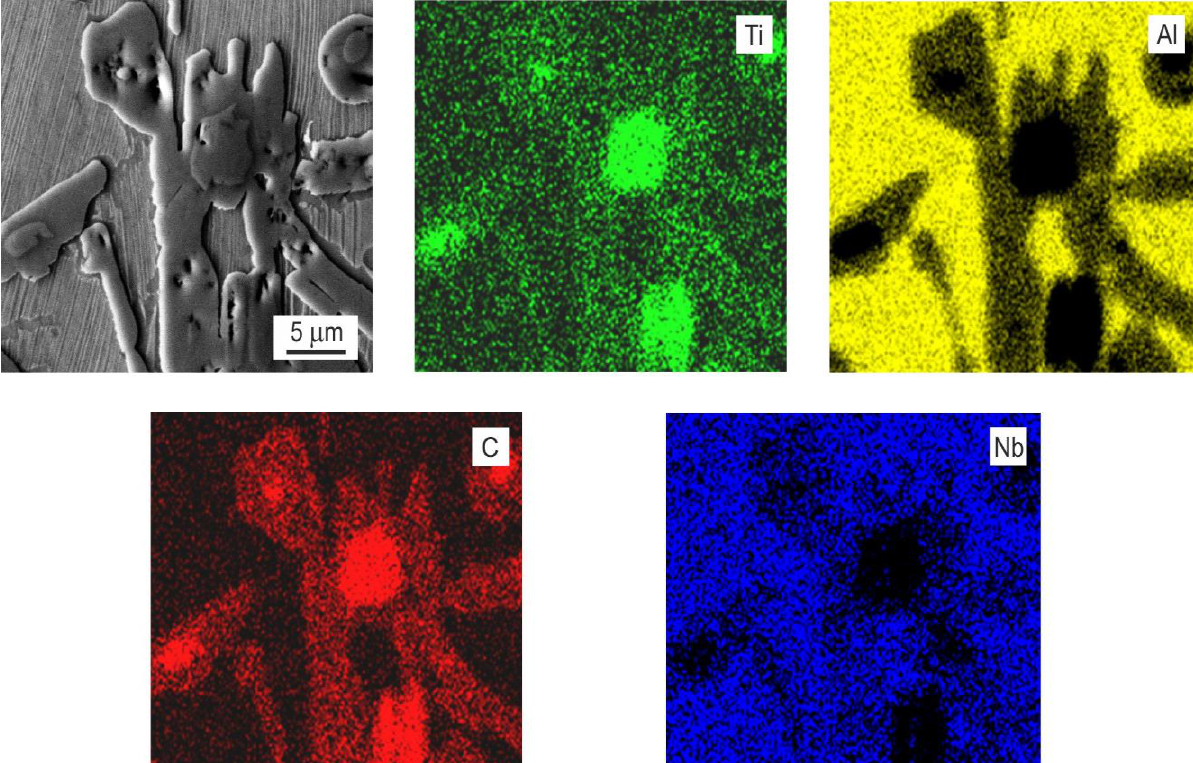
Figure 3. SEM micrograph and corresponding EDS map analysis of the tilt-cast Nb alloy.